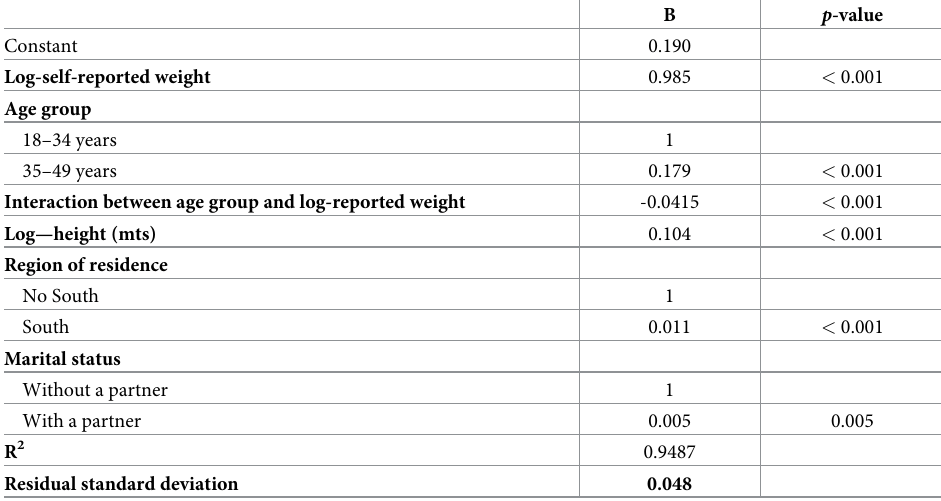
Table 3. Regression coefficients for estimating log-weight from log-self-reported